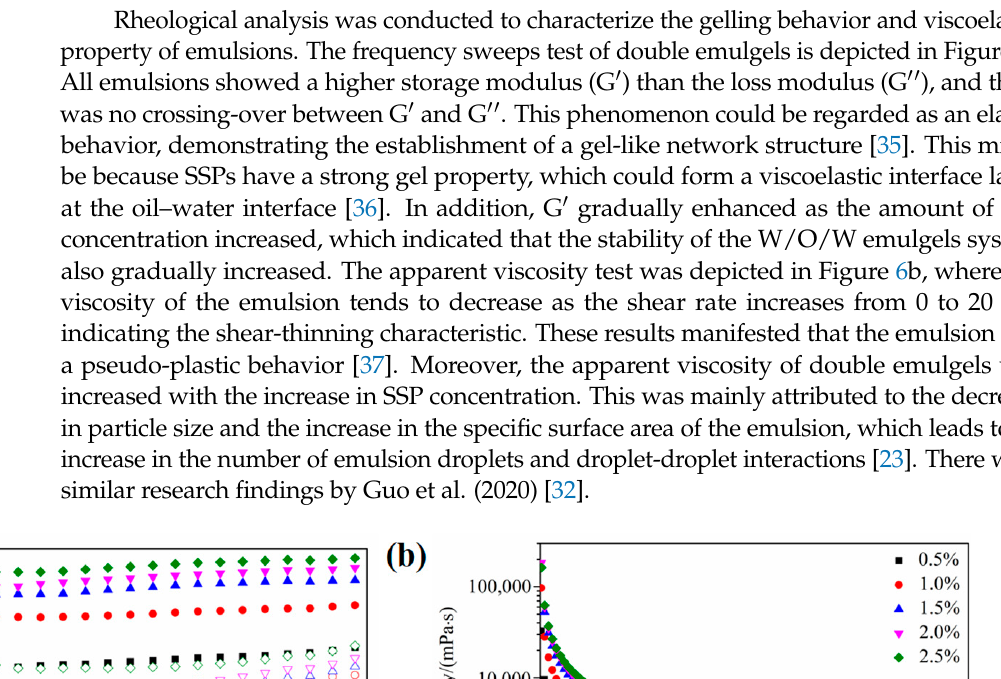
Figure 6. The frequency sweep curves ( a ) and apparent viscosity ( b ) of W 1 /O/W 2 emulgels (W 1 /O primary emulsion, 10%) with different concentrations of SSPs. Scale bars, 20 μ m.